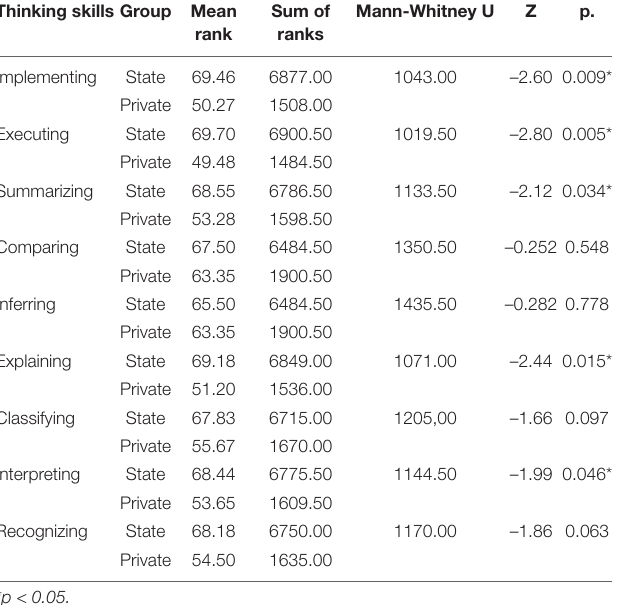
TABLE 5 | Non-parametric results of cognitive process practice according to the level of content and language integrated learning (CLIL) teacher training. Thinking CLIL Mean skills training